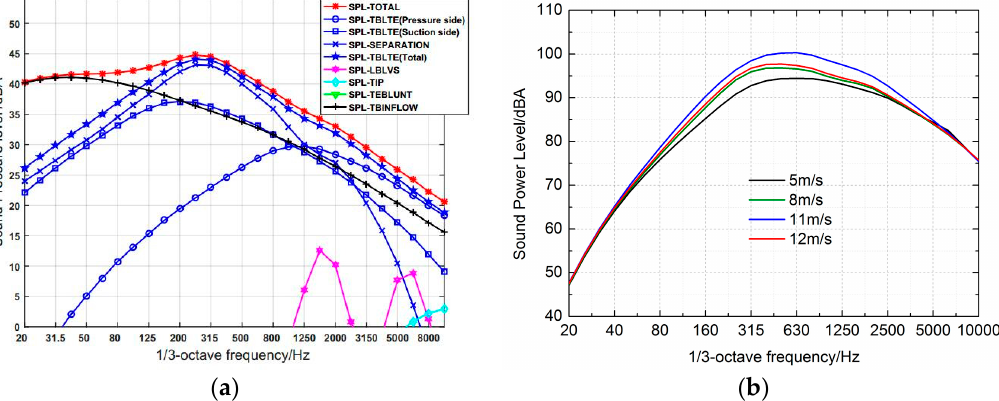
Figure 9. The wind turbine noise source ( a ) sound pressure level, 12 m/s; ( b ) sound power level with the different inflow wind velocity, 5 m/s, 8 m/s, 11 m/s, 12 m/s.